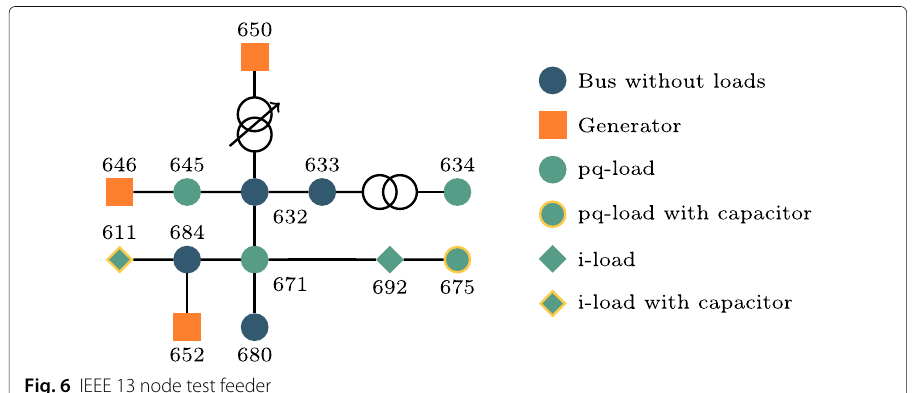
Fig. 6 IEEE 13 node test